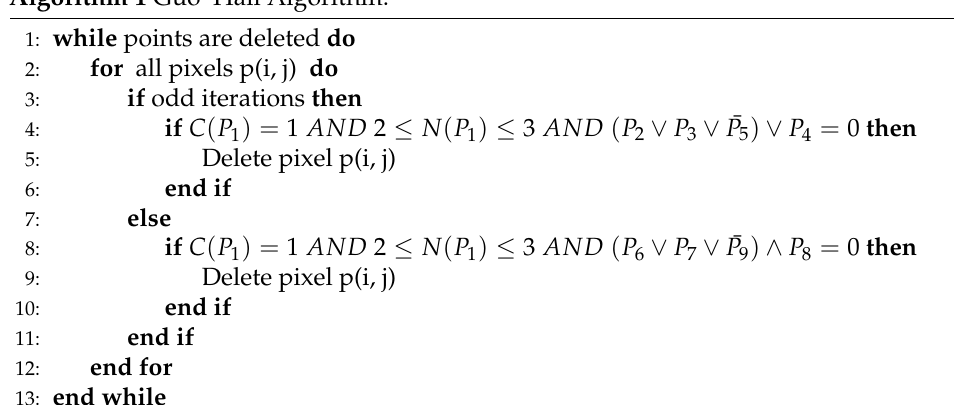
Algorithm 1 Guo–Hall